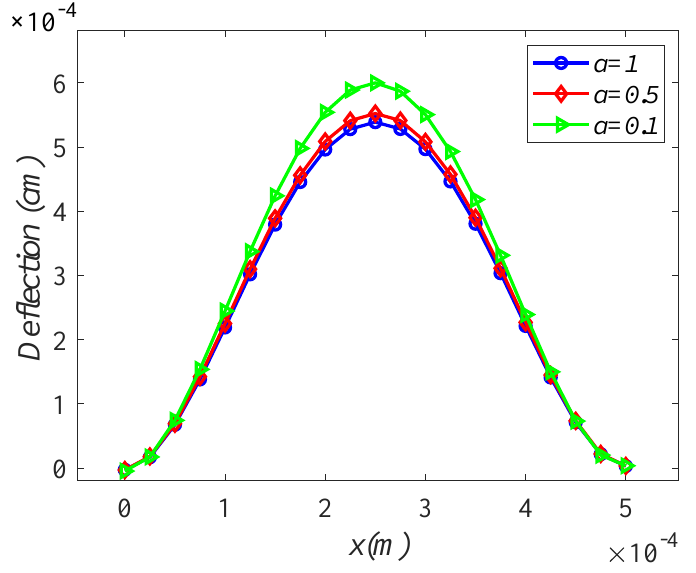
Figure 3. Effect of different viscous damping coefficients on deflection of the micro-beam.